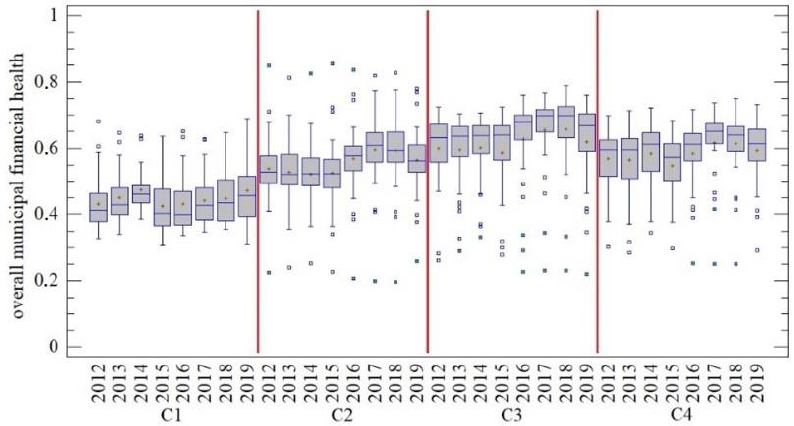
Figure 4. The overall financial health of municipalities based on three indicators (C1, C2, C3, and C4) during the 2012–2019 period.